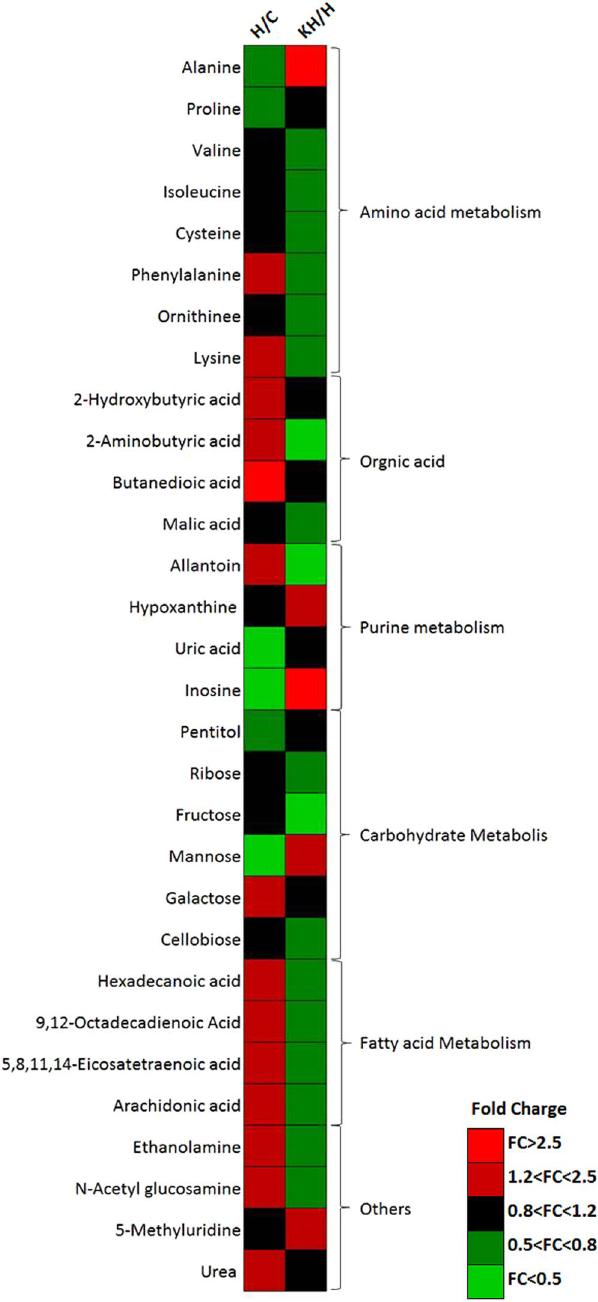
Figure 7. Fold changes of the arithmetic mean values (p < 0.05) of heat-induced changes in liver metabolites by Kisspeptin administration at the study end point. C: control group; H: Heat stress group; KH group: Kisspeptin + Heat stress